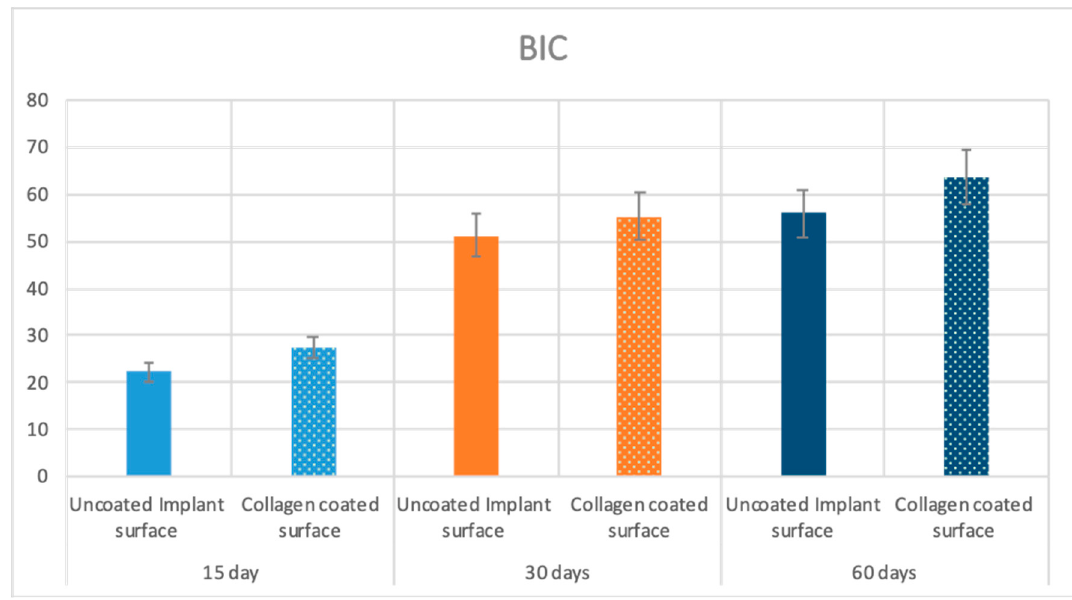
Figure 9. Means and SD of the measured BIC ratios at 15, 30 and 60 days. Y axis is bone implant contact expressed in %.